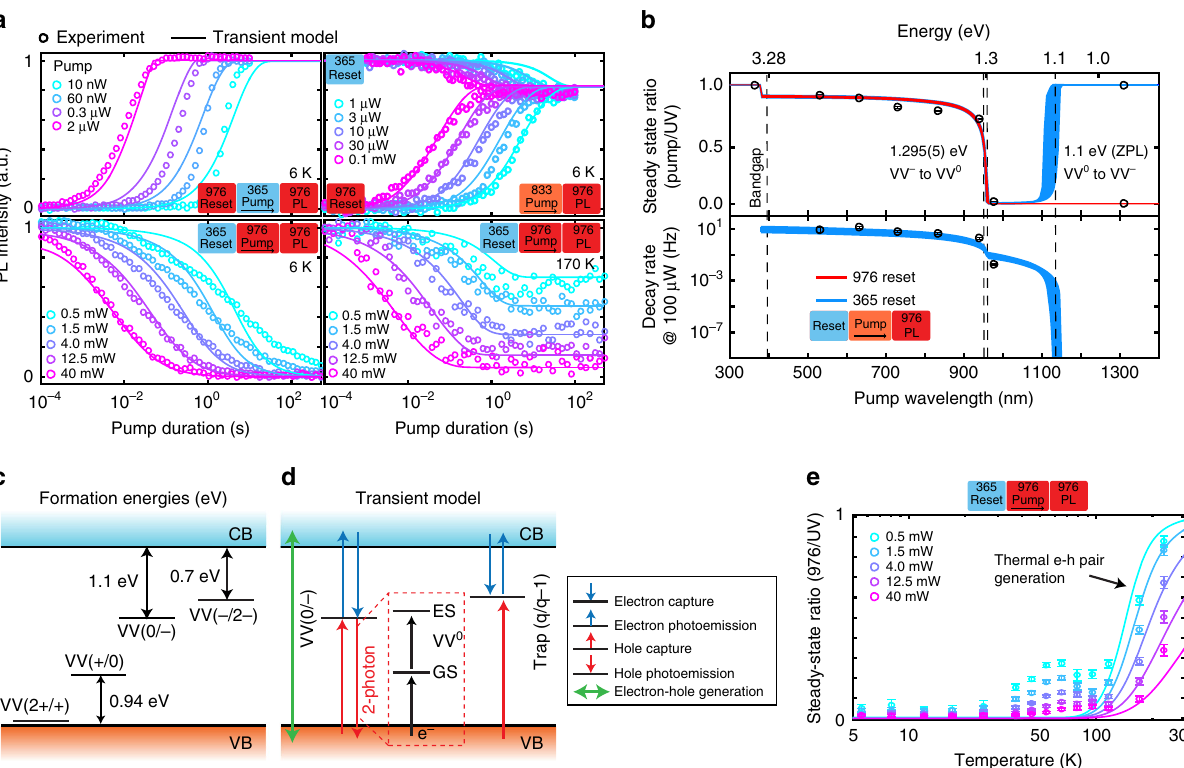
Fig. 3 Photo-dynamics and modeling in neutral divacancies in 4H-SiC. The charge dynamics is probed using two and three color experiments, following a reset-pump-measure scheme. a Typical decay curves obtained under various reset/pump wavelength and temperatures. The fi t (line) is obtained from the model given in d . b Top fi gure: ratio between pump and 365 nm steady-state PL intensities. Bottom fi gure: decay rates (normalized to 100 μ W at every pump wavelength) obtained by fi tting the decays in a with a stretched exponential function (error bars are 95% con fi dence intervals from the fi t). In blue, the sequence starts after 365 nm pumping, while in red, after 976 nm. The lines are given by the model in d , with the area corresponding to 95% con fi dence intervals. For 1310 nm, no signi fi cant decay was observed over 100 s, hence the steady-state values are given without error bars. c Formation energies of the divacancy in 4H-SiC, taken from 20 . d Model used for simulating all transients in a , b , e , including the VV 0 and VV − levels of the divacancy, as well as an unknown trap with two charge states. Processes included in the model are given in the legend. Hole photo-emission converting VV 0 to VV − involves a two-photon process, exciting VV 0 from its ground state to its excited state, followed by excitation and capture of an electron from the valence band. e Temperature dependence of the steady state after 976 nm pumping (365 nm reset). Error bars are 95% con fi dence intervals from the decays ’ stretched exponential fi t. Lines are given by the model in d , corresponding to thermal generation of electron-hole (e-h) pairs. The origin of the intermediate region between 30 and 100 K is unknown. Above 210 K, PL5 and PL6 signals become dominant, making the measurement unreliable as they are